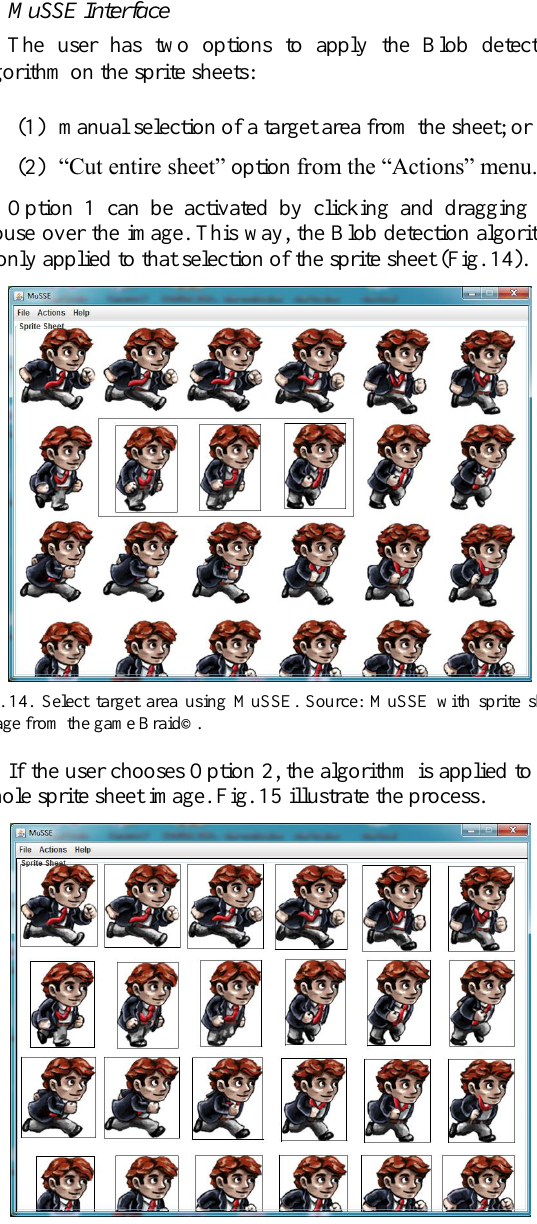
Fig. 15. Select entire sprite sheet using MuSSE. Source: MuSSE with sprite sheet image from the game